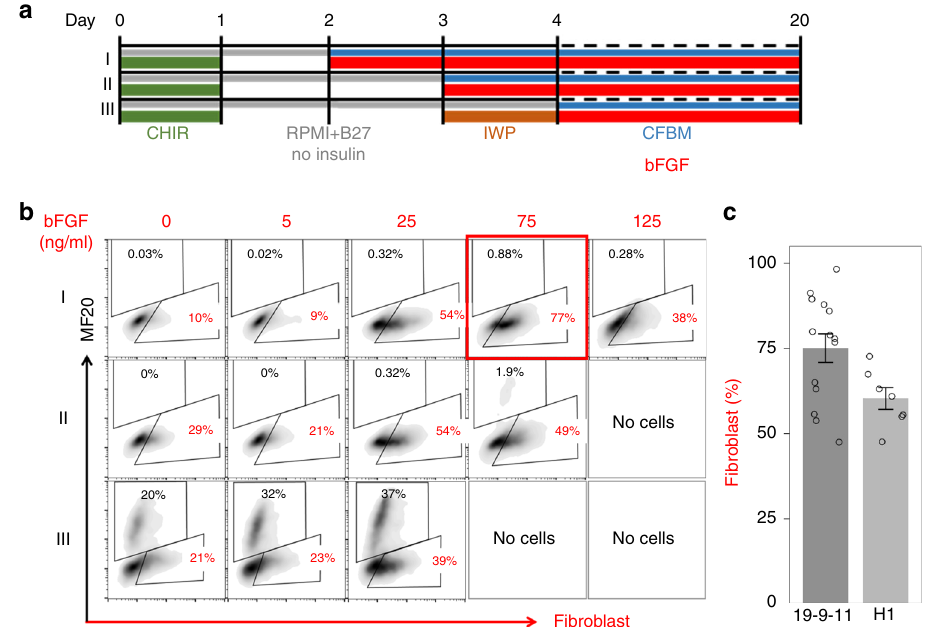
Fig. 2 Effect of bFGF on hPSC-derived mesodermal and cardiac progenitors. a Schematic for testing the concentration-dependent effect of bFGF addition to stage-speci fi c progenitors generated by the GiWi protocol beginning bFGF on day 2, 3, or 4, corresponding to labeled protocols I, II, and III. Gray lines indicate RPMI medium + B27 without insulin supplement; blue lines indicate cardiac fi broblast basal medium (CFBM); green lines indicate CHIR treatment; red lines indicate bFGF treatment; orange line indicates IWP treatment. b Flow cytometry analysis of day 20 differentiated cells from protocols I, II, III labeled by human fi broblast marker (clone TE-7 antibody) and cardiomyocyte marker (MF20 antibody for sarcomeric myosin). c Average percentage of fi broblast population differentiated from hESC line H1 ( n = 7, biological replicates) and hiPSC line DF19-9-11T ( n = 14, biological replicates) at 20 days. Data are mean ±